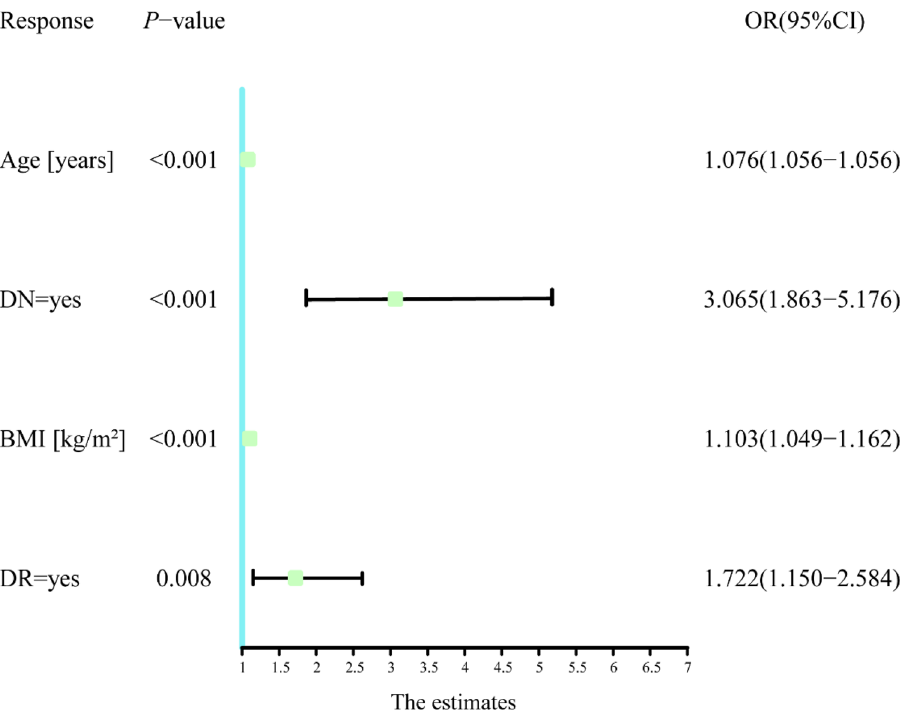
Figure 2. Forest plot for building the OR of the 4 variables of the